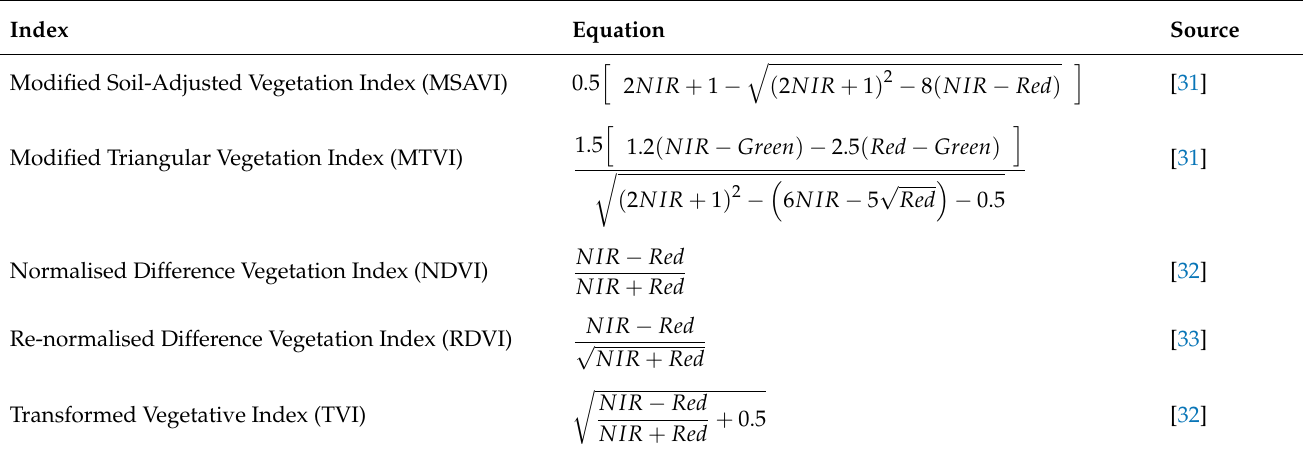
Table 4. Chosen vegetation